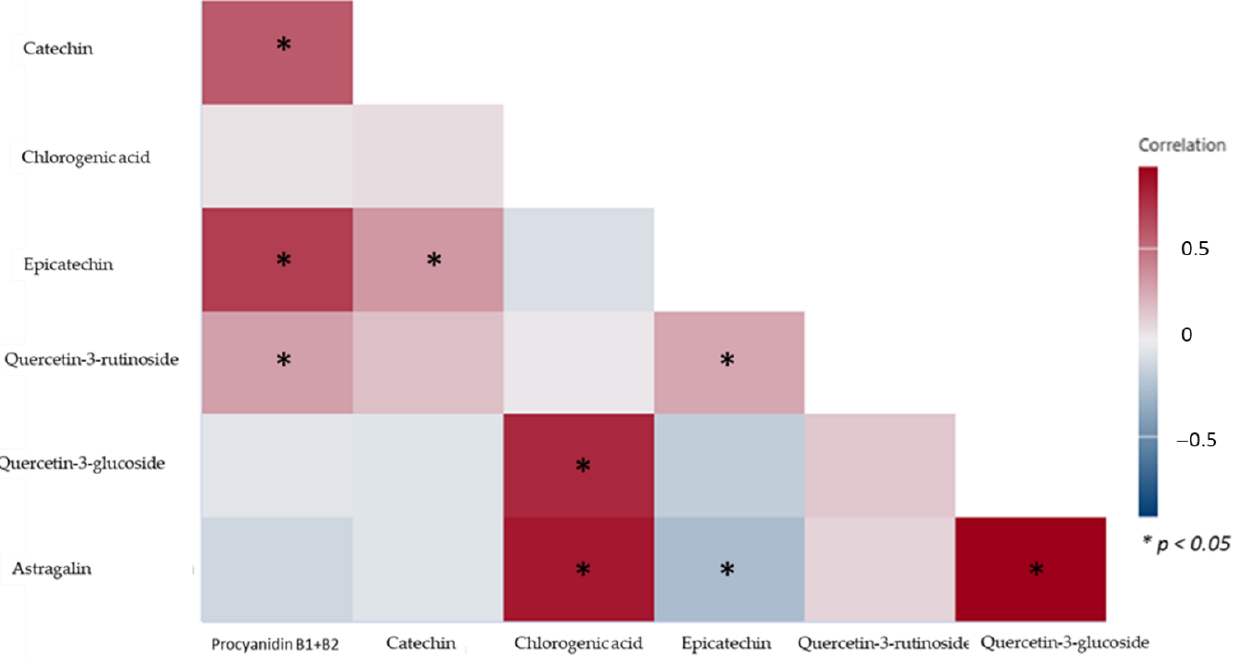
Figure 1. The colour map of correlations between polyphenols in 23 Croatian traditional apple varieties, * statistically significant negative or positive correlation.